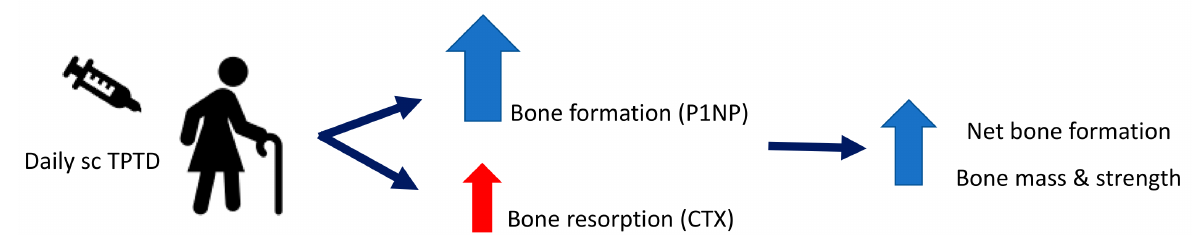
Figure 1. Mechanism of action of subcutaneous (sc) Teriparatide (TPTD). Teriparatide stimulates bone formation, reflected by an increase in the bone formation marker P1NP (procollagen type 1N propeptide) and increases bone resorption, as reflected by an increase in the bone resorption marker CTX (c-terminal telopeptide). Bone formation is greater than bone resorption leading to net bone formation with increased bone mass and